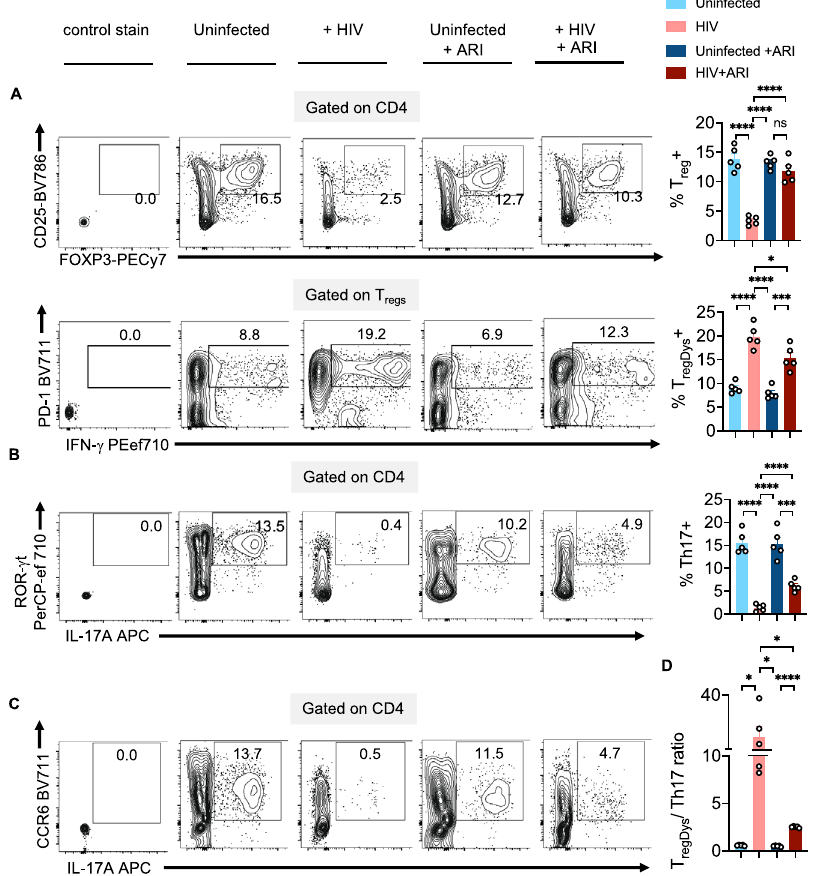
Fig. 2 | HIV infection causes Th dysregulation that sustained even after ARI treatment. TCR-stimulatedHTOCwasinfectedwithHIV.Controlcultureswerenot infected (Uninfected). In some cultures, ARI was added the next day to block subsequent rounds of infection. Cells were allowed to expand in the presence of TGF- β 1 (10ng/ml) and IL-2 (100U/ml) for 6 days. A FOXP3 and CD25 expression (top) and PD-1 and IFN- γ expression (bottom) in CD4 + (CD3 + CD8 neg ) FOXP3 + cells, showingthefrequencyofT regs andT regDys .ExpressionofIL-17AandROR- γ t( B ),and